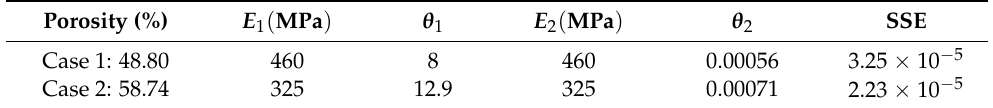
Table 5. Derived model parameters of predicted compressive stress